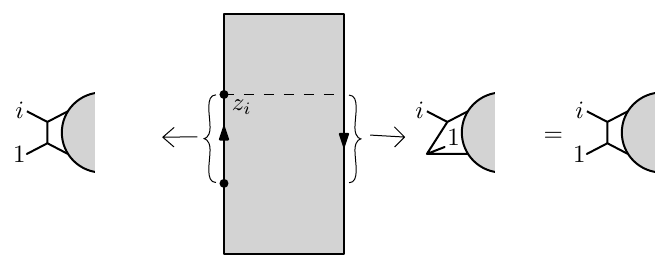
Figure 6 . Contributions from different boundaries that cancel each